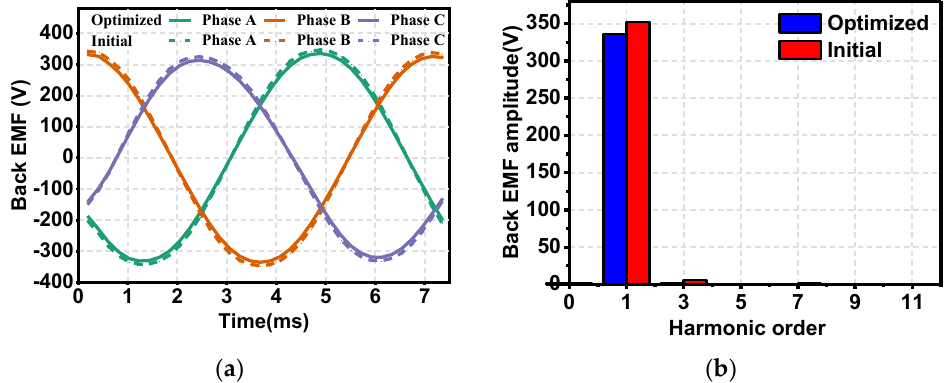
Figure 8. The no-load back EMF of the SCM-AFPM motors. ( a ) The no-load back EMF waveform